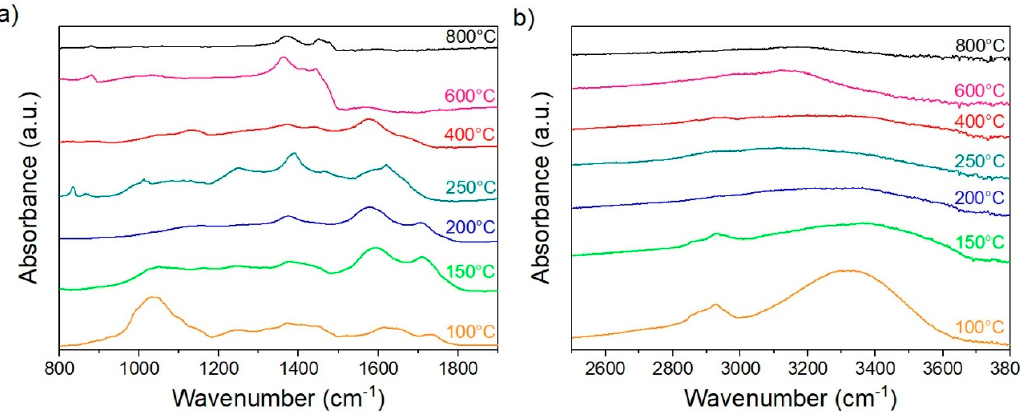
Figure 5. Fourier-transform infrared (FTIR) spectra of CP were processed at different temperatures in the range of wavenumber of 800–1900 cm − 1 ( a ) and 2500–3800 cm − 1 ( b ).